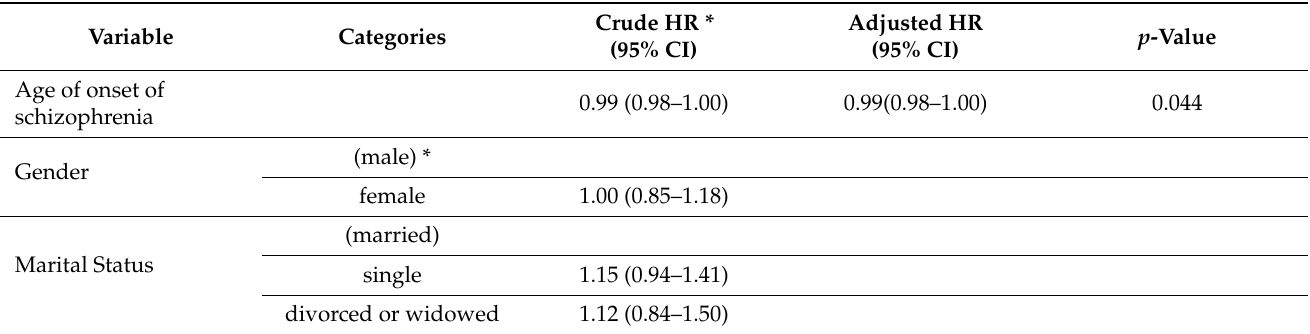
Table 2. Crude and adjusted Shared Log-Normal Frailty model parameter